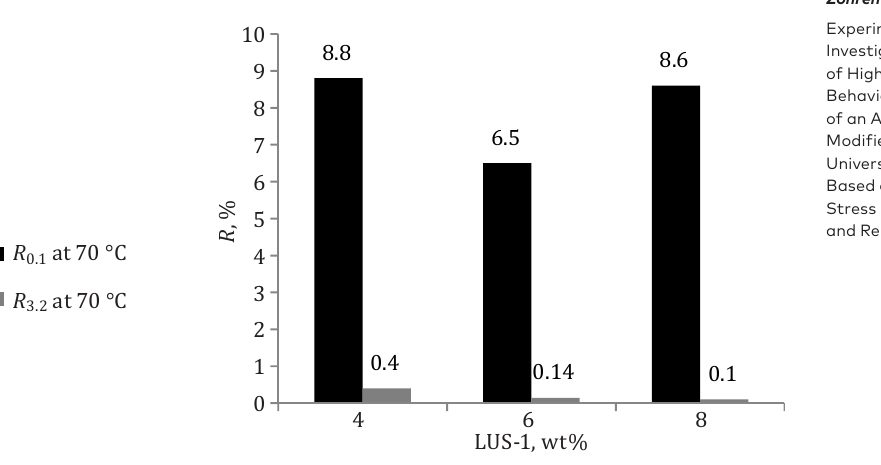
Figure 17. Effect of stress levels on recovery percent of asphalt binders at 70